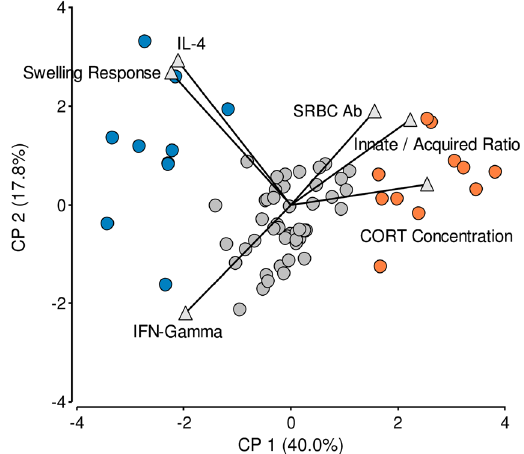
Figure 1. Exploration of data variability and clustering procedure. Principal component analysis bi-plot graphs. Each bird is represented by a dot and each explanatory and clustering variable used in the analysis is represented by triangle. Total distribution of the data categorized according to the birds’ assignation according to k-means clustering. Full blue dots and full orange dots represent extreme clusters with low and high basal CORT concentration respectively; full grey dots represent birds with intermediate configuration. The eigenvalues are shown in brackets next to each component. Number of birds in the study: